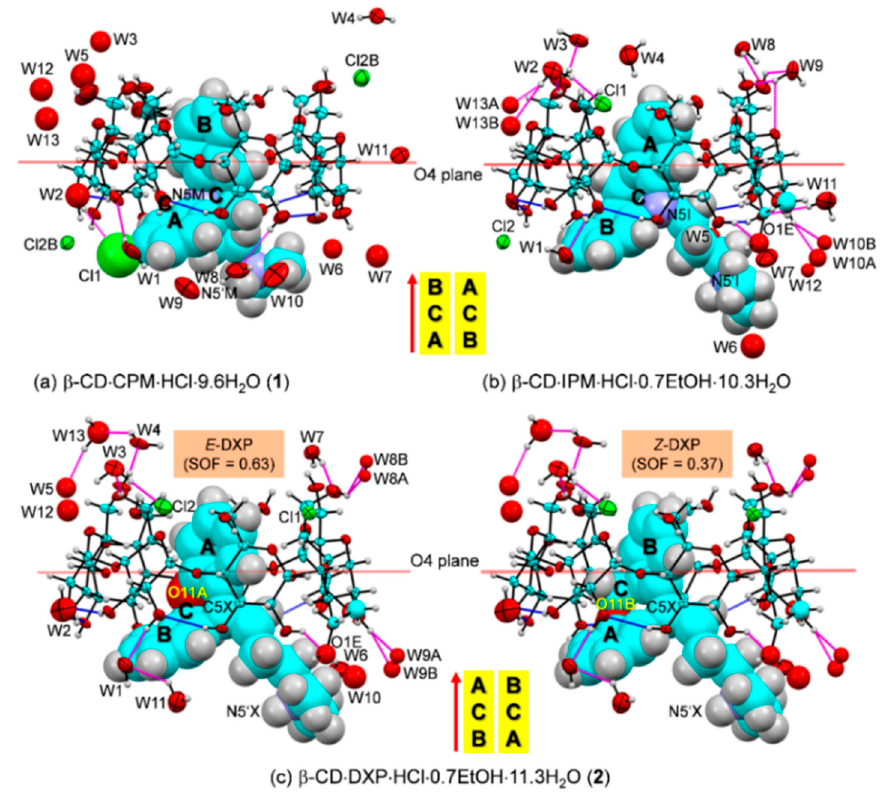
Figure 4. ORTEP diagrams (30% probability level) of inclusion complexes ( a ) β -CD–CPM HCl at 296 K ( 1 ), ( b ) β -CD–IPM HCl at 296 K [15], and ( c ) β -CD–DXP HCl at 296 K ( 2 ). For better visibility, the guest molecules are displayed in space-filling model. The O–H · · · O hydrogen bonds within β -CD and between other molecules are shown with blue and magenta connecting lines, respectively; see also Figure 5. Note that the different inclusion structures from the distinct alignments of the A-C-B-rings of drugs CPM, IPM, and DXP are emphasized in the middle; see also Figure 3.